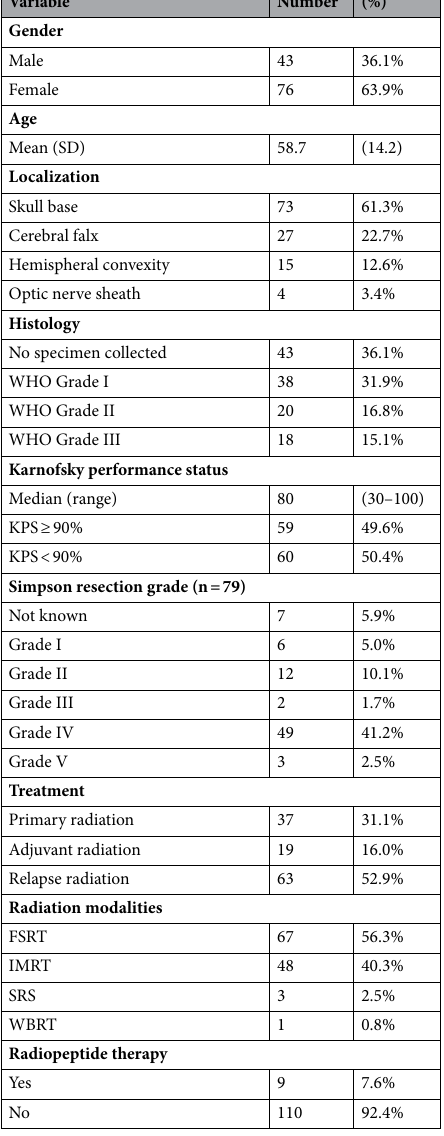
Table 1. Patient characteristics (n = 119). FSRT = fractionated stereotactic radiotherapy; IMRT = intensity modulated radiotherapy; SD = standard deviation; SRS = stereotactic radiosurgery; WBRT = whole brain radiotherapy; WHO = World Health